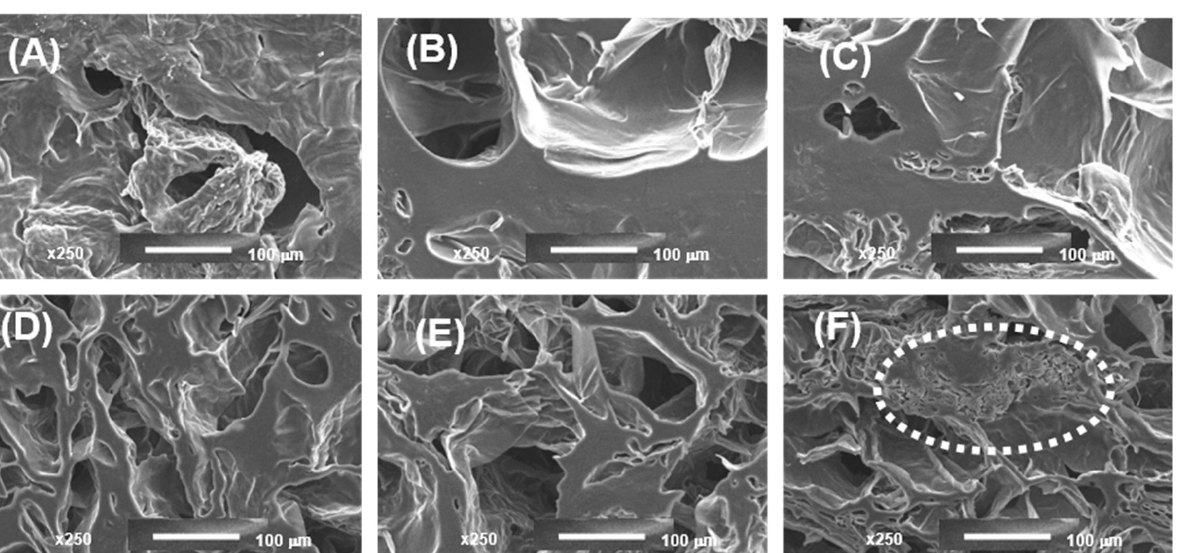
Figure 8. Scanning electron micrographs of the 3D ‐ printed gel containing LA16 ‐ 66 callus at ( A ) mag ‐ nification 500×; scale bar 50 μ m and ( B ) magnification 1000×; scale bar 10 μ m. The arrows indicate the area of dense folded formation. EDS analysis revealed similar contents of oxygen (87–92 wt%) in the 3D ‐ printed gels containing LA14 and LA16 calluses. It has been established that the content of the K + cat ‐ ion in the gel increased with an increase in the concentration of callus in the ink. The K + cation content was 3.9 ± 0.0, 5.0 ± 0.2, and 6.5 ± 0.0 wt% in LA14 ‐ 33, LA14 ‐ 50, and LA14 ‐